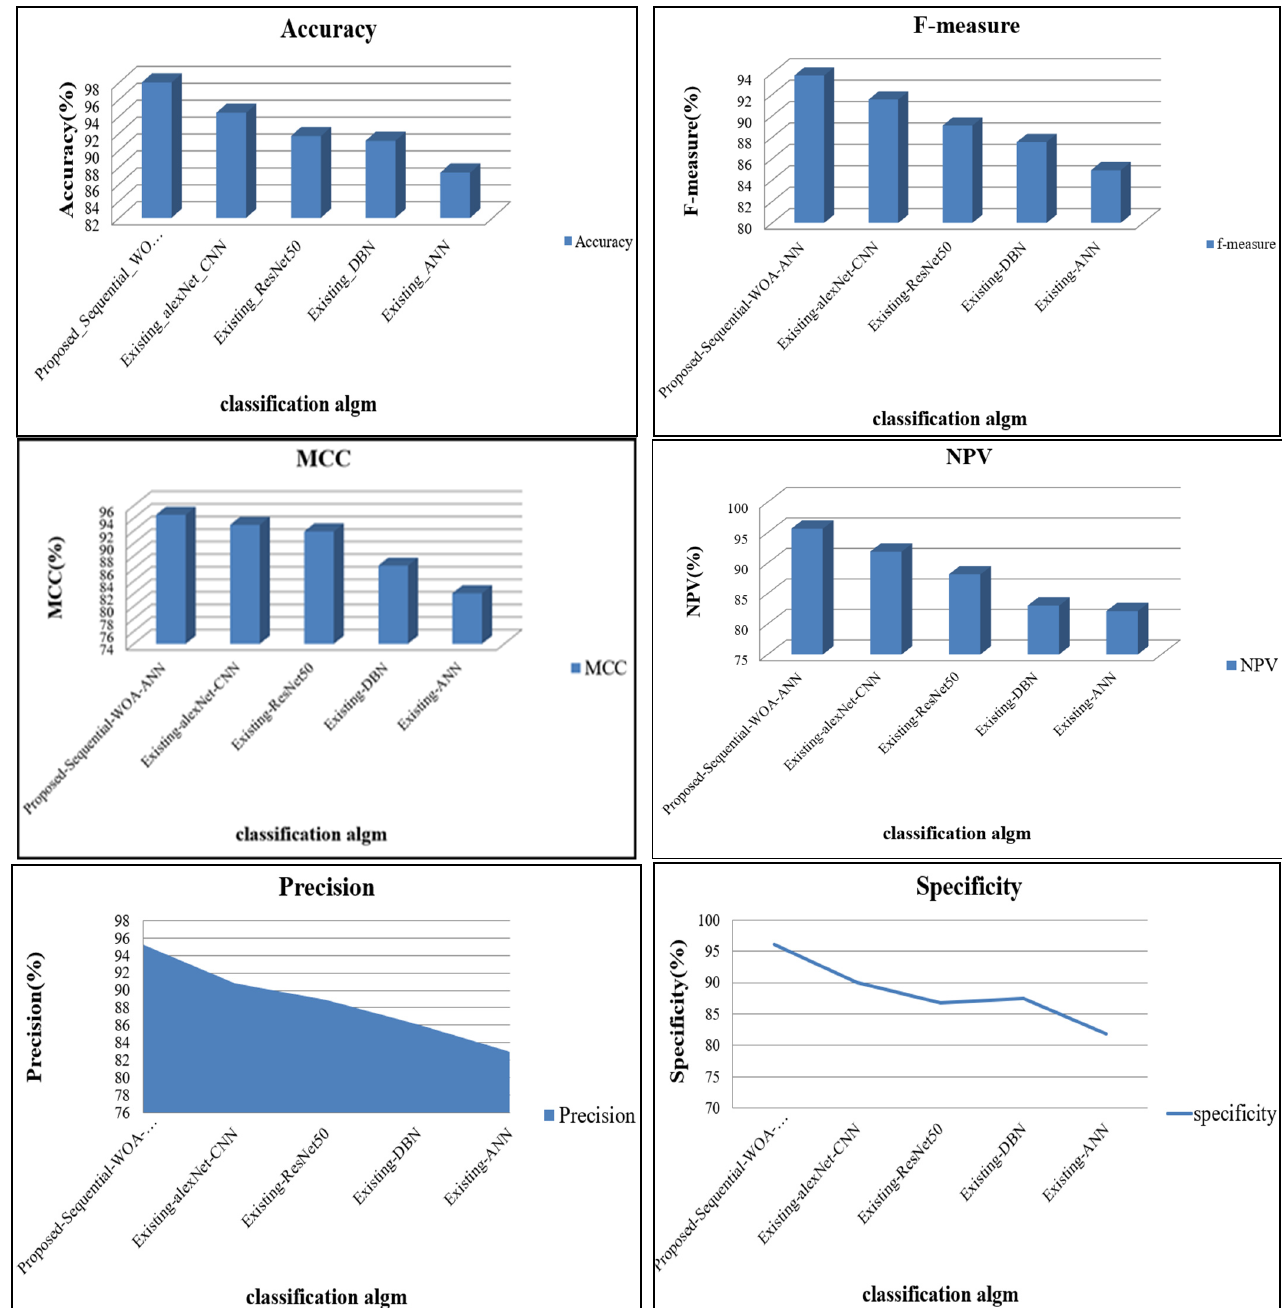
Figure 9. Classification metrics for sequential model architecture.